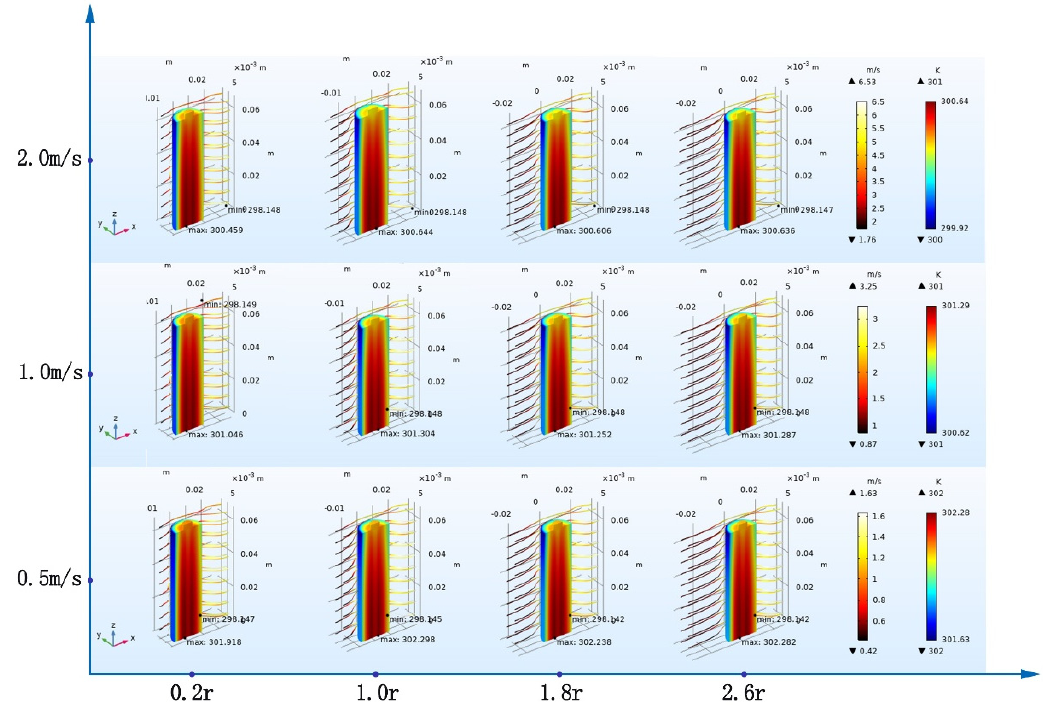
Figure 14. Internal temperature distribution of batteries at different air velocity and inlet flow area size.